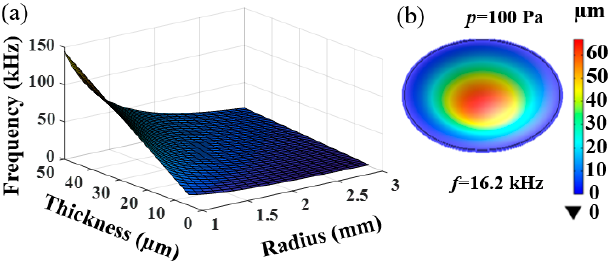
Figure 1. ( a ) Simulation of resonant frequency versus the thickness and radius of the diaphragm and ( b ) a resonant mode of the diaphragm at a frequency of 16.2 kHz.